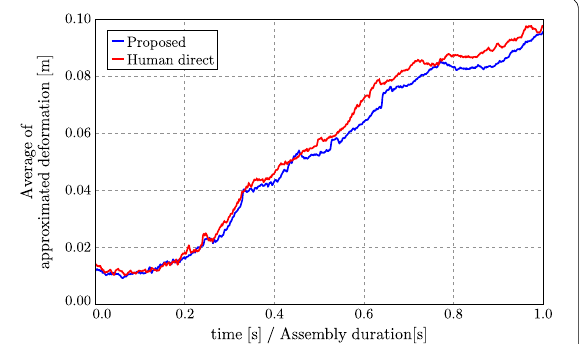
Fig. 11 Average of the approximated deformation of the silicon o‑ring over six trials per method. The time is normalized by the assembly duration time